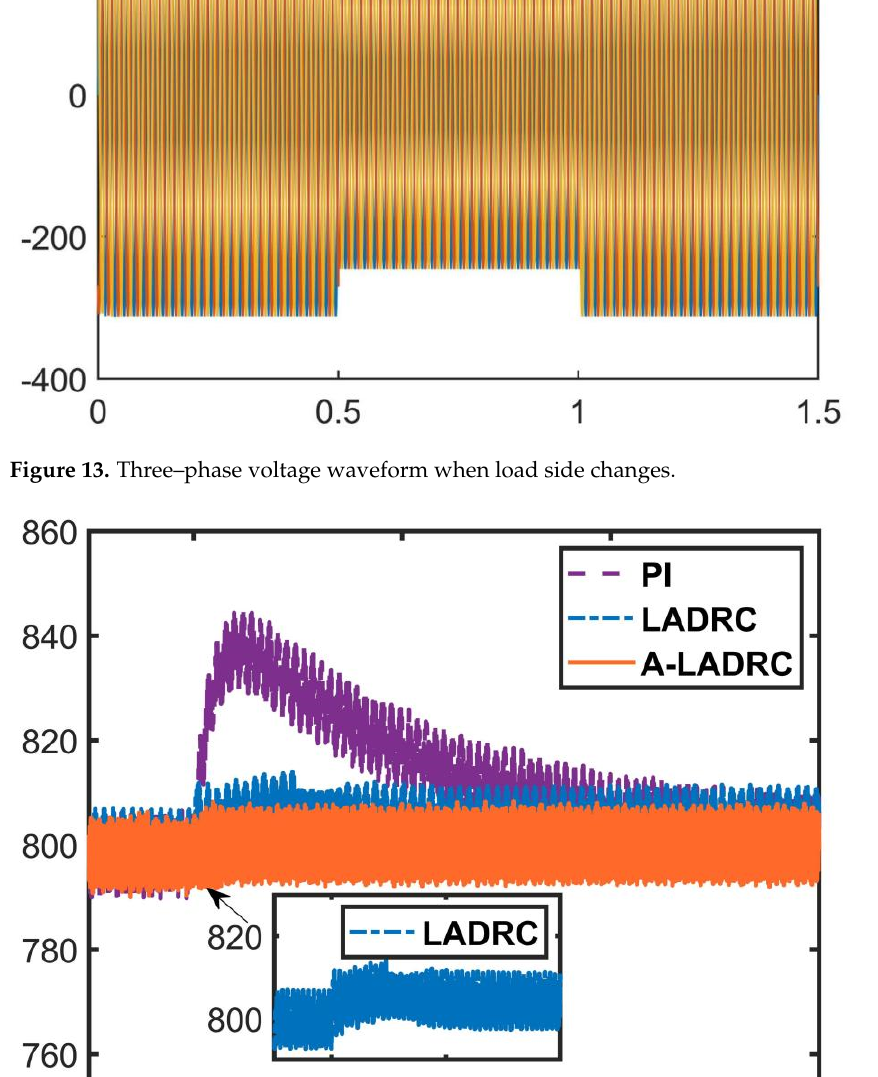
Figure 15. DC bus voltage waveform during fault recovery. 6. Discussion The analysis of the results of Examples 2 and 3 shows that the bus voltage of the PI controller fluctuates greatly in the face of external interference and the recovery time is long. When the disturbance occurs, LADRC estimates the influence caused by the disturbance through LESO, and compensates the total disturbance through the PD controller, which enhances the stability and robustness of the system. Therefore, the dynamic process when interference occurs is optimized. From Examples 1, 2, and 3, it shows that the traditional LADRC is often difficult to set the optimal value in the face of complex external interference. This paper proposes the addition of an adaptive control